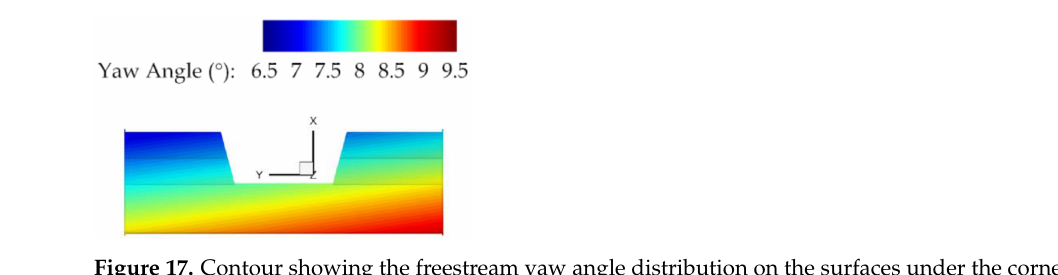
Figure 17. Contour showing the freestream yaw angle distribution on the surfaces under the corner- ing condition.